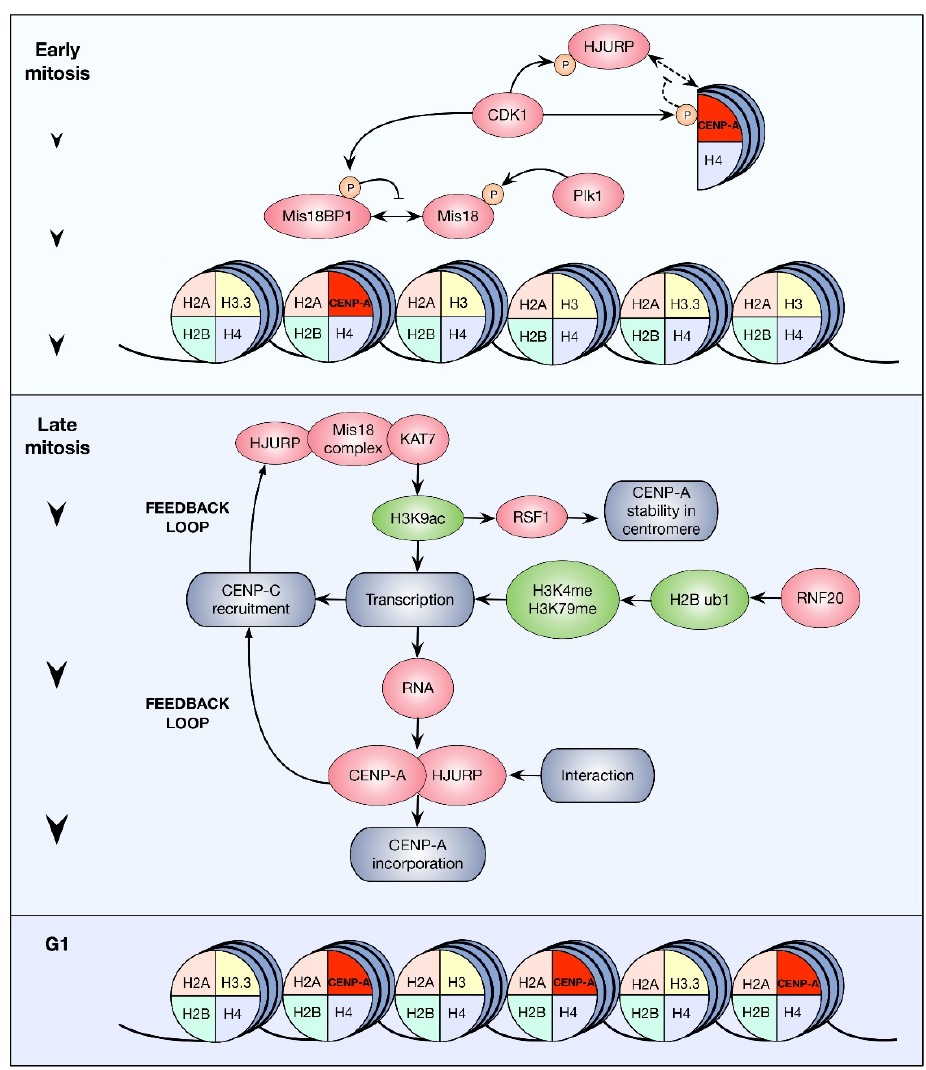
Figure 3. Roles of HPTMs in CENP-A incorporation. In every cell cycle, half of the CENP-A nucleosomes from each centromere are loaded onto the nascent DNA strand during DNA replication. As a result, G2 centromeres show half of the CENP-A nucleosomes that G1 centromeres have. The incorporation of new CENP-A nucleosomes remains inhibited during G2 and early mitosis by specific phosphorylations on histone and non-histone proteins (upper panel). These phosphorylations prevent the formation of key complexes for CENP-A incorporation, such as the Mis18BP1 complex. However, CENP-A nucleosome levels are replenished during late mitosis/early G1. The methylation, acetylation, and ubiquitination of different histones are required during the process (middle and lower panel). This cascade of events involves at least two feedback loops, ultimately leading to increased CENP ‐ A incorporation. HPTMs are depicted in green, proteins and RNA in pink, and processes in grey.